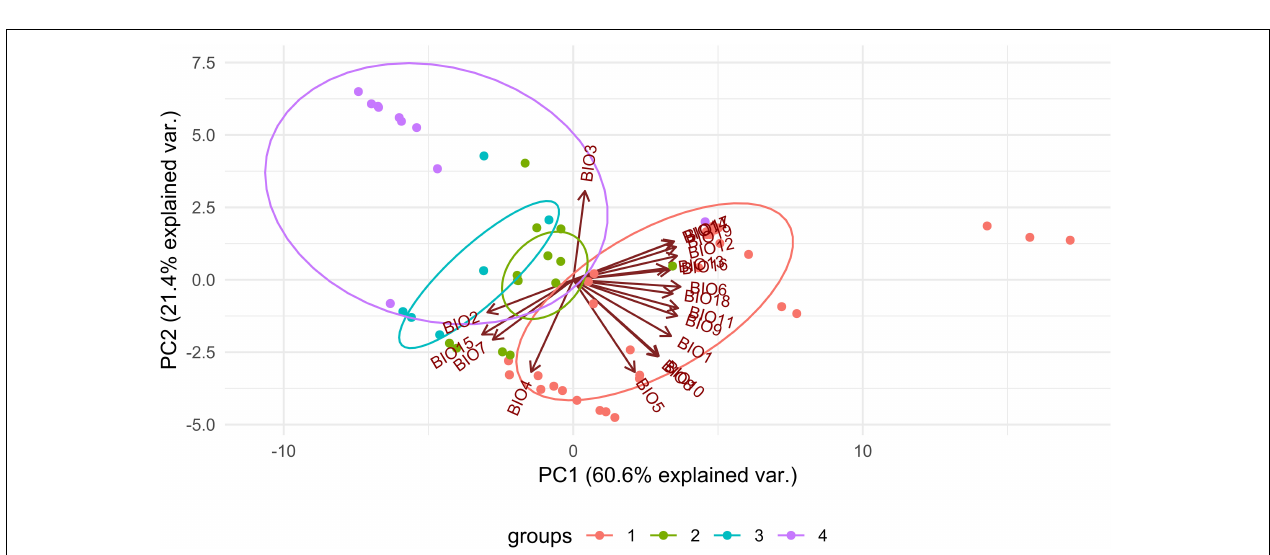
FIGURE 5 | Bar graphs showing the percentage of specimens originating from open high Andean vegetation (red), upper montane cloud forest 2 (orange), upper montane cloud forest 1 (yellow) and lower montane cloud forest (green) in each Trebouxia lineage.